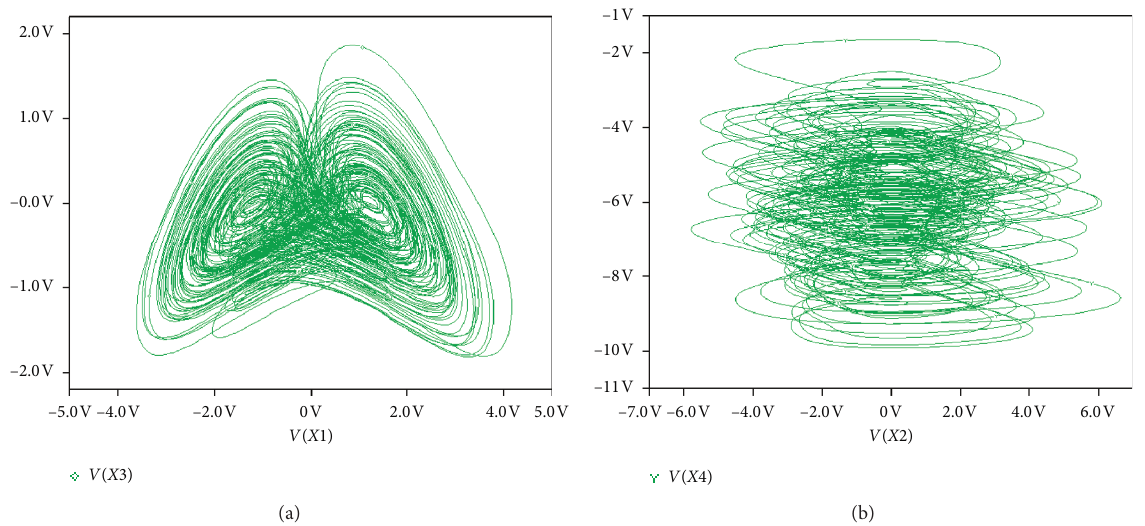
Figure 11: A chaotic attractor of system (2) obtained from the analog circuit for R − x − x ; (b) x . (a) x 1 3 2 4